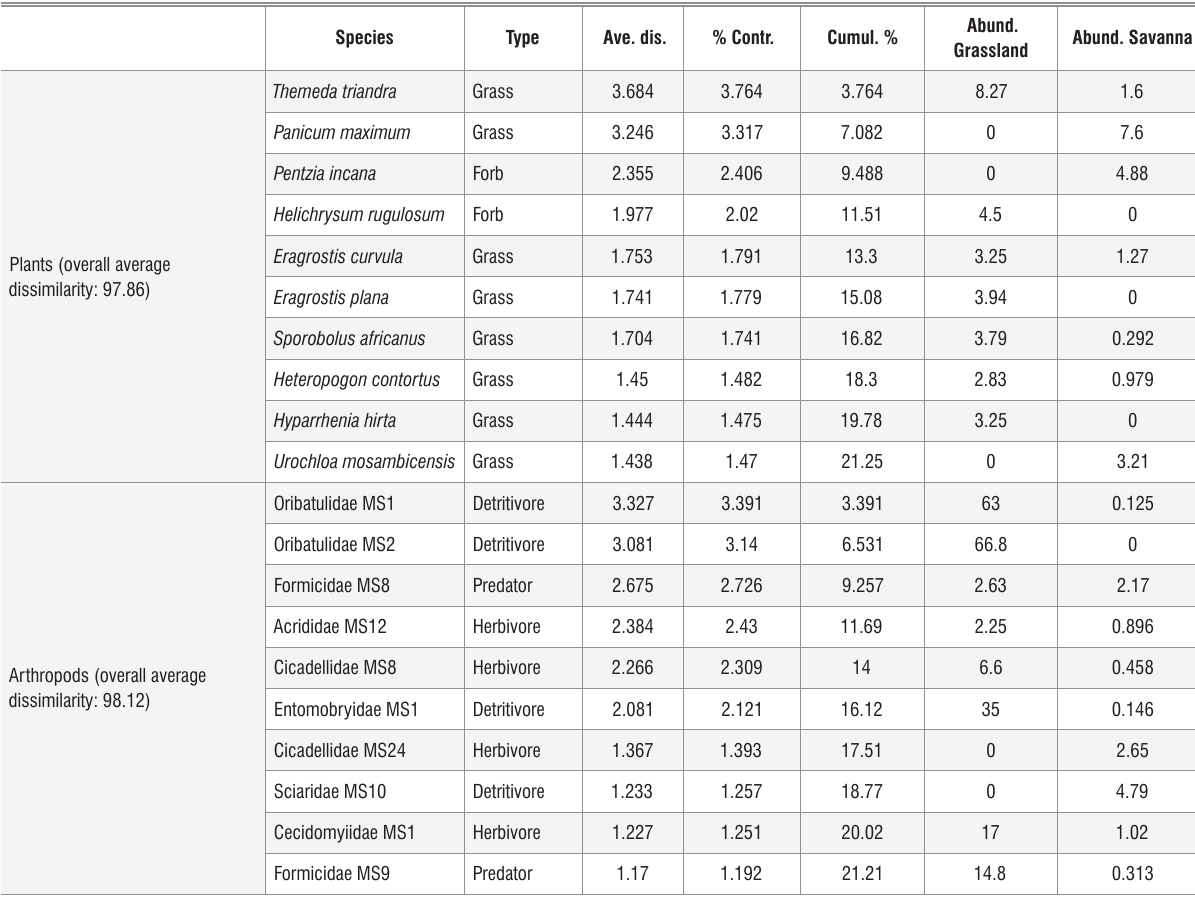
Table 4: Results for SIMPER analyses indicating the top ten plant and arthropod species responsible for groupings of grassland and savanna plots in the NMDS graphs Species Type Ave. dis. % Contr. Cumul. %